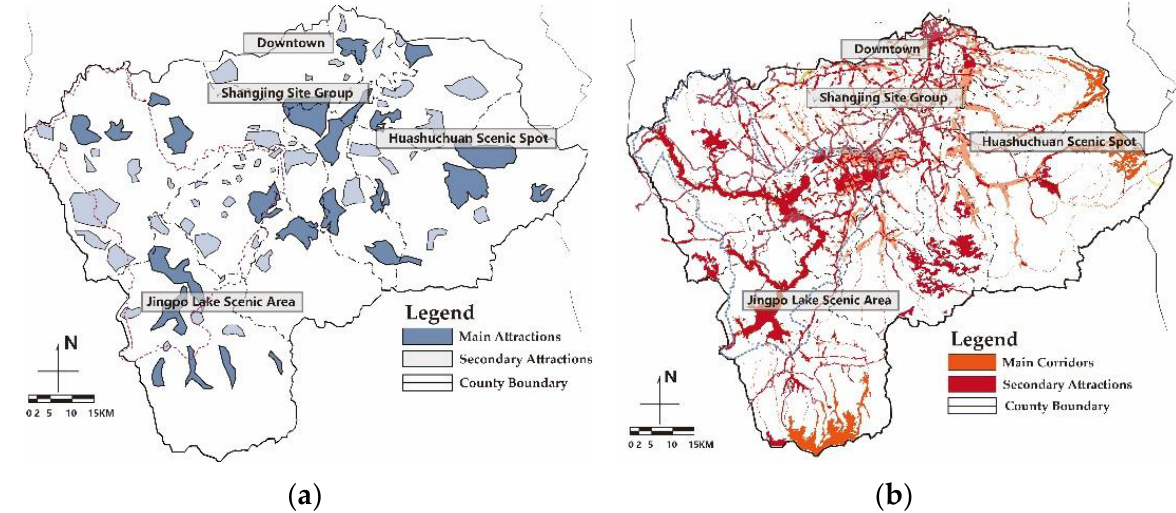
Figure 6. Spatial distribution of tourism resources in Ning’an: ( a ) resource node distributions and ( b ) resource corridor distributions.